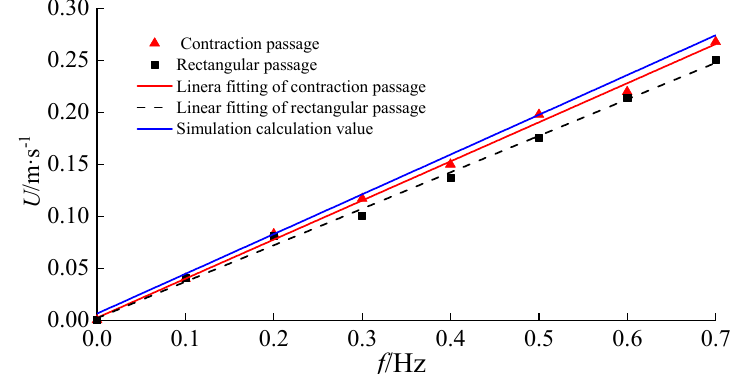
Figure 15. Comparison of flow velocity between test and simulation.